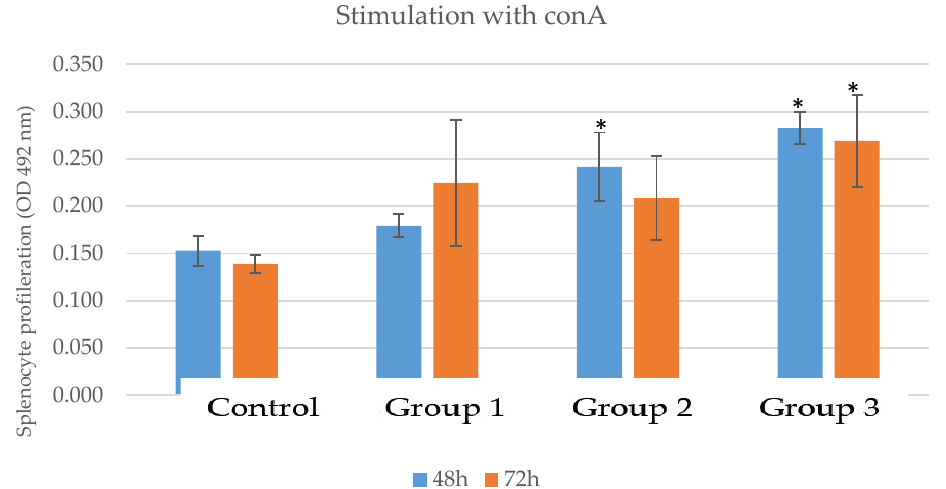
Figure 15. Lymphocyte proliferation capacity levels in the groups that received the novel nutraceutical compared to the control group—stimulation with conA; * = p value < 0.05.